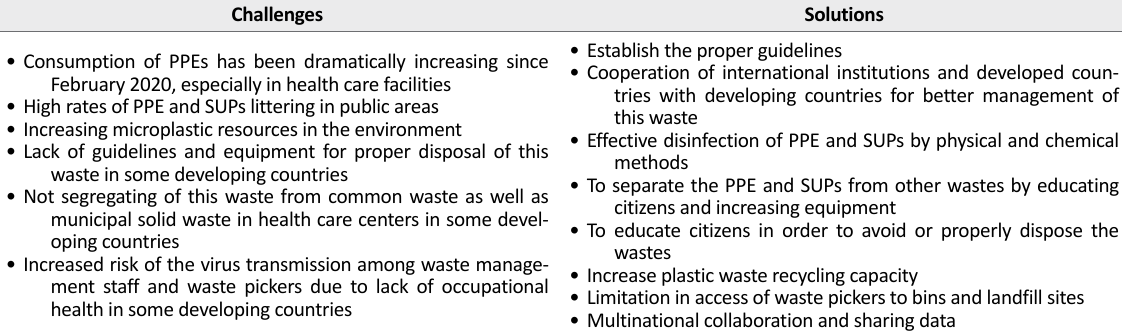
Table 1. Solid waste management affected by increased PPE and SUPs consumption Challenges